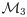
Extrapolated infection trajectory for the US based on the model M3.Posterior mean of the maximum number of cumulative infected cases is is 1,760,569 cases. Posterior means for the flat time points are tflat,γ=0.9 = May 30th, tflat,γ=0.99 = July 16th, tflat,γ=0.999 = August 30th, and tflat,γ = 0.9999 = October 15th.